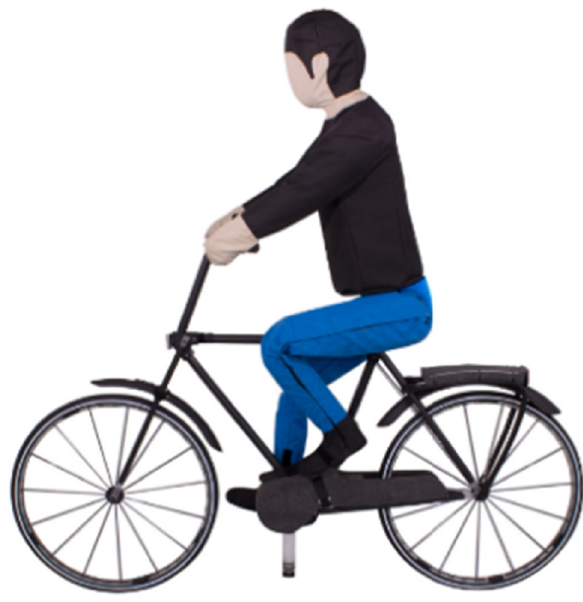
Figure 6: Cyclist dummy. Source: “ authors ” own sources.